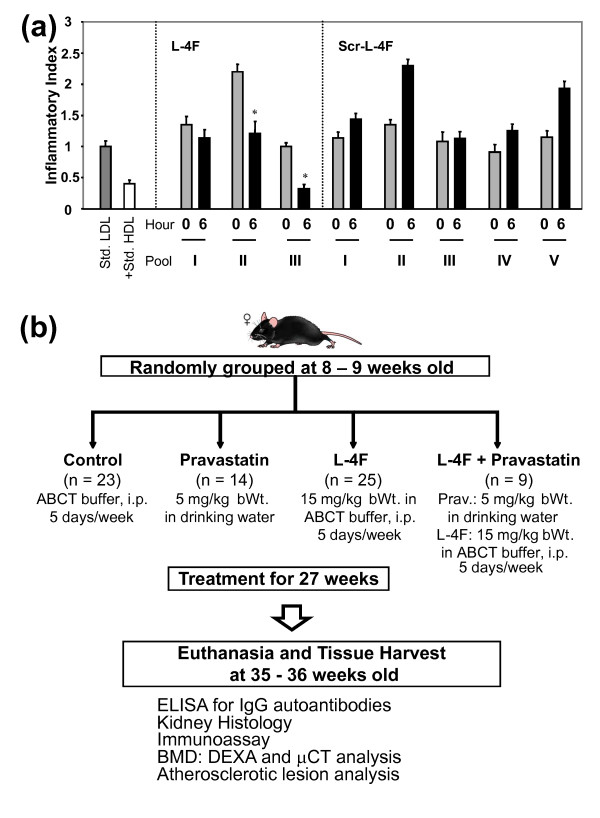
Preliminary studies and experimental protocol. (a) Preliminary studies to determine the use of L-4F as a potential treatment in apoE-/-Fas-/- mice showed that HDL taken six hours after injection of L-4F was more successful in reducing LDL-induced monocyte chemotactic activity in cultures of human aortic endothelial cells compared to scrambled L-4F (Scr-L-4F). The value for No Addition (no LDL or HDL added to endothelial cultures) was subtracted from all values, the value for Std. LDL was taken as 1.0 and inflammatory index for LDL + HDL was calculated. Each pool represents HDL fractions from three to four mice. (b) Thirty-six week experimental protocol. *P ≤ 0.05.